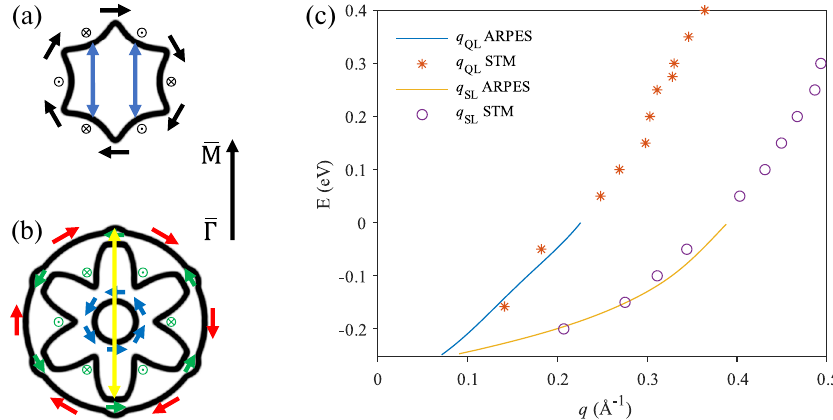
FIG. 4. Dispersion of Γ − M scattering edges from ARPES and FT STS. (a),(b) Schematic of CCEs resulting in the edges of q vectors ¯ Γ − ¯ M observed in the FT STS maps along the direction; arrows mark the spin orientation on these topological surface states: on the QL termination (a), the circular shape surface band is slightly warped for E > − 100 meV, causing a canted spin along z , thus resulting in q marked by the blue arrows; on the SL termination (b), for E > − 150 meV, Rashba-like spin splitting contributes antiparallel QL helicity for the inner and outer rings in the CCE map (marked as blue and red arrows), where the outer ring hybridizes with a strongly warped surface band sandwiched in between. The middle warped band has the same helicity as the inner circular bands to fit the intensity ¯ Γ − ¯ M marked by the yellow arrow. (c) Dispersion of the q vectors calculated from the along the direction in the QPI map, leading to q SL ARPES data (solid lines) on the QL (blue) and SL (yellow) terminations and the q vectors obtained from the FT STS data (orange stars for QL and purple circles for SL). The original FT STS and CCE maps are shown in Figs. S6 – S9 [32],